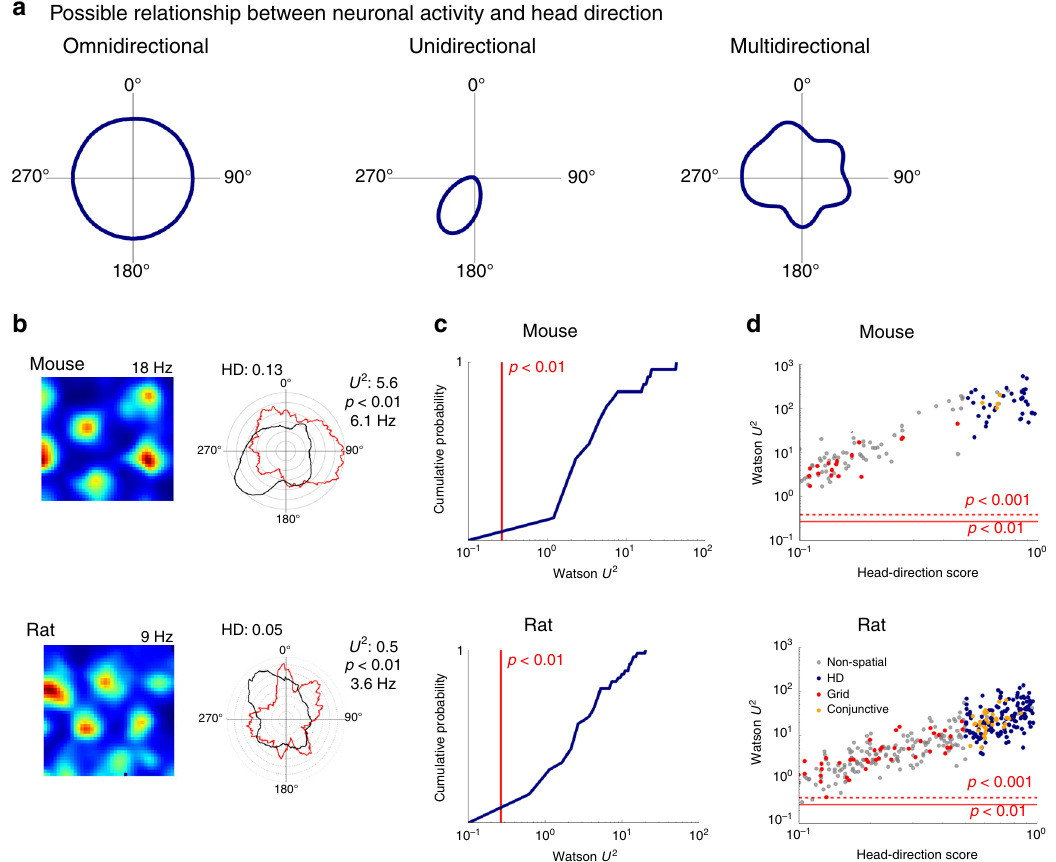
Fig. 1 Grid cell fi ring is modulated by head direction. a Schematics of omnidirectional, unidirectional and multidirectional tuning. b Examples of fi ring rate maps (left) and head direction histograms (right) for grid cells from mice (upper) and rats (lower). Polar histograms show binned counts of head direction across all video frames (black) and the mean fi ring rate for each head direction bin (red). The head direction score (HD), two-sided Watson U 2 test statistic and corresponding signi fi cance estimate and maximum fi ring rates for each cell are indicated adjacent to the polar plot. c Cumulative probability of the two-sample Watson U 2 test statistic comparing the distribution of head directions when each cell fi red with the distribution of head directions for the entire trajectory within the recording session (mice: p < 0.001 for 34/34 cells, rats: p < 0.01 for 68/68 cells). d Two-sample Watson test statistics plotted as a function of head direction score for pure grid cells (red), head direction cells (blue), conjunctive cells (orange) and other cells (grey). The red lines indicate signi fi cance levels p < 0.001 (dashed) and p < 0.01